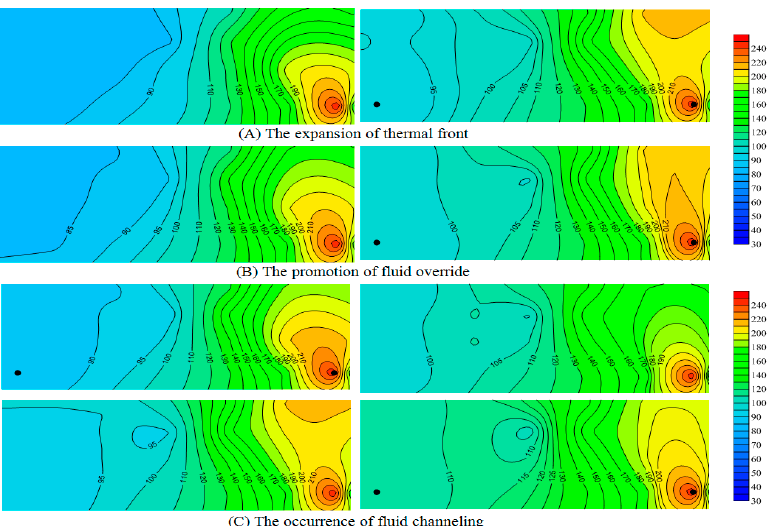
Figure 5. Temperature distribution in different stages of nitrogen-assisted steam flooding [94].